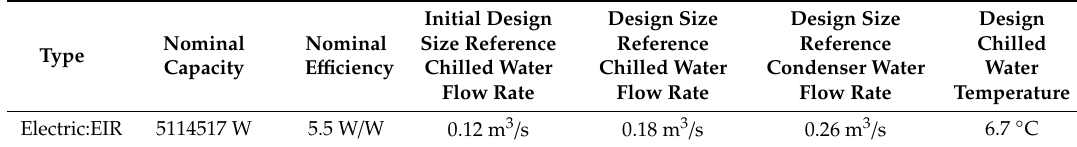
Table 2. Chiller specification.